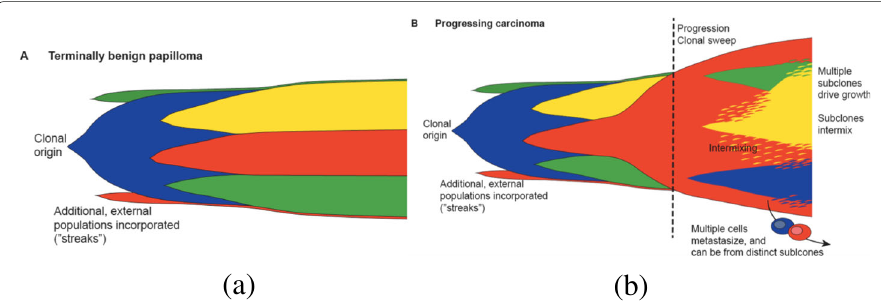
Fig. 2 A depiction of the growth patterns of terminally benign papillomas ( a ) and an example of those that progress to become invasive carcinomas ( b ), followed by spreading beyond the tumor margins to distant sites (Metastasis). Colors represent groups of cells that have arisen from one original colored cell (clones). a The major blue color represents the original clone that arose from the first initiated cell, and subsequently gave rise to the broad yellow, red and green clones during papilloma growth. Papillomas also incorporate normal clones of cells (streaks) that are mainly at the periphery of the tumor (thin red and green clones). The new papilloma clones do not generally intermix inter- mix, and only one will progress to malignancy. b Progression to malignancy and metastasis. At the benign-malignant transition, a clonal sweep results in the emergence of a single red dominant clone, but this is followed by generation of new clones that show evidence of intermixing. This property has only been seen thus far in malignant tumors. Two or more of these intermixing clones can cooperate to drive growth and